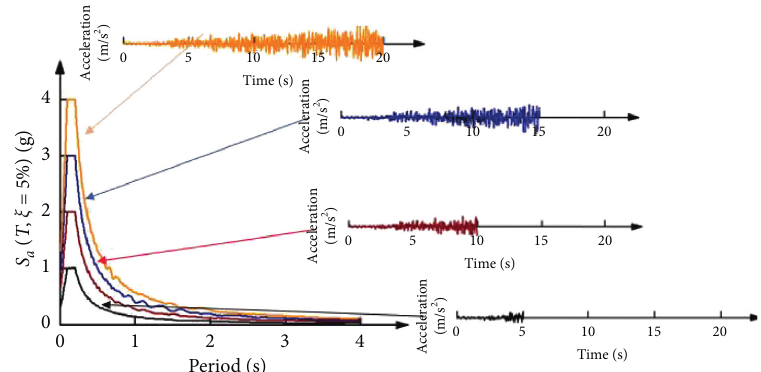
Figure 1: The incremental relationship of acceleration response spectrum to ETAH.